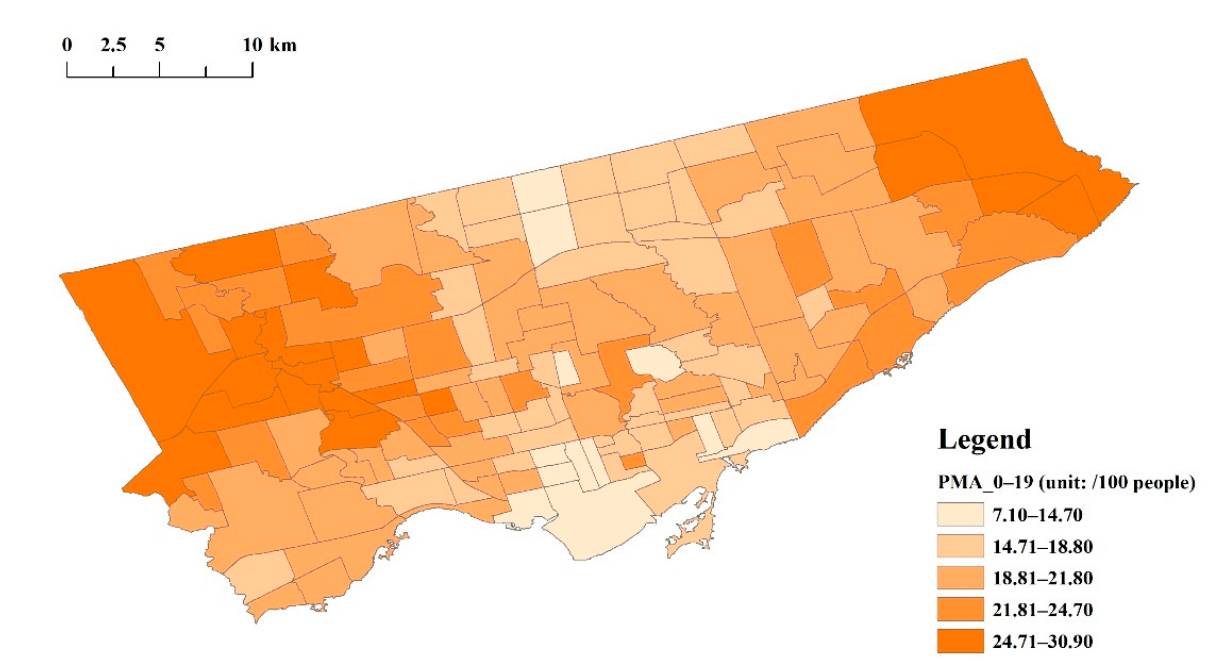
Figure A5. Distribution of the prevalence of male asthmatics aged 0–19 years (PMA_0–19).